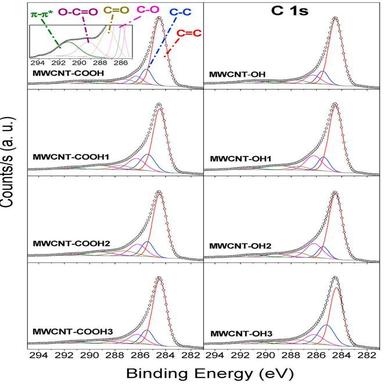
High-resolution C 1s spectra (dots) for the MWCNTs before and after the green synthesis for both functionalizations (OH and COOH) with the corresponding chemical components (colored lines), named C– –C, C–C, C–O, C– –O, O–C– –O, π-π\, are displayed in increasing binding energy order. (For interpretation of the references to color in this figure legend, the reader is referred to the Web version of this article.)